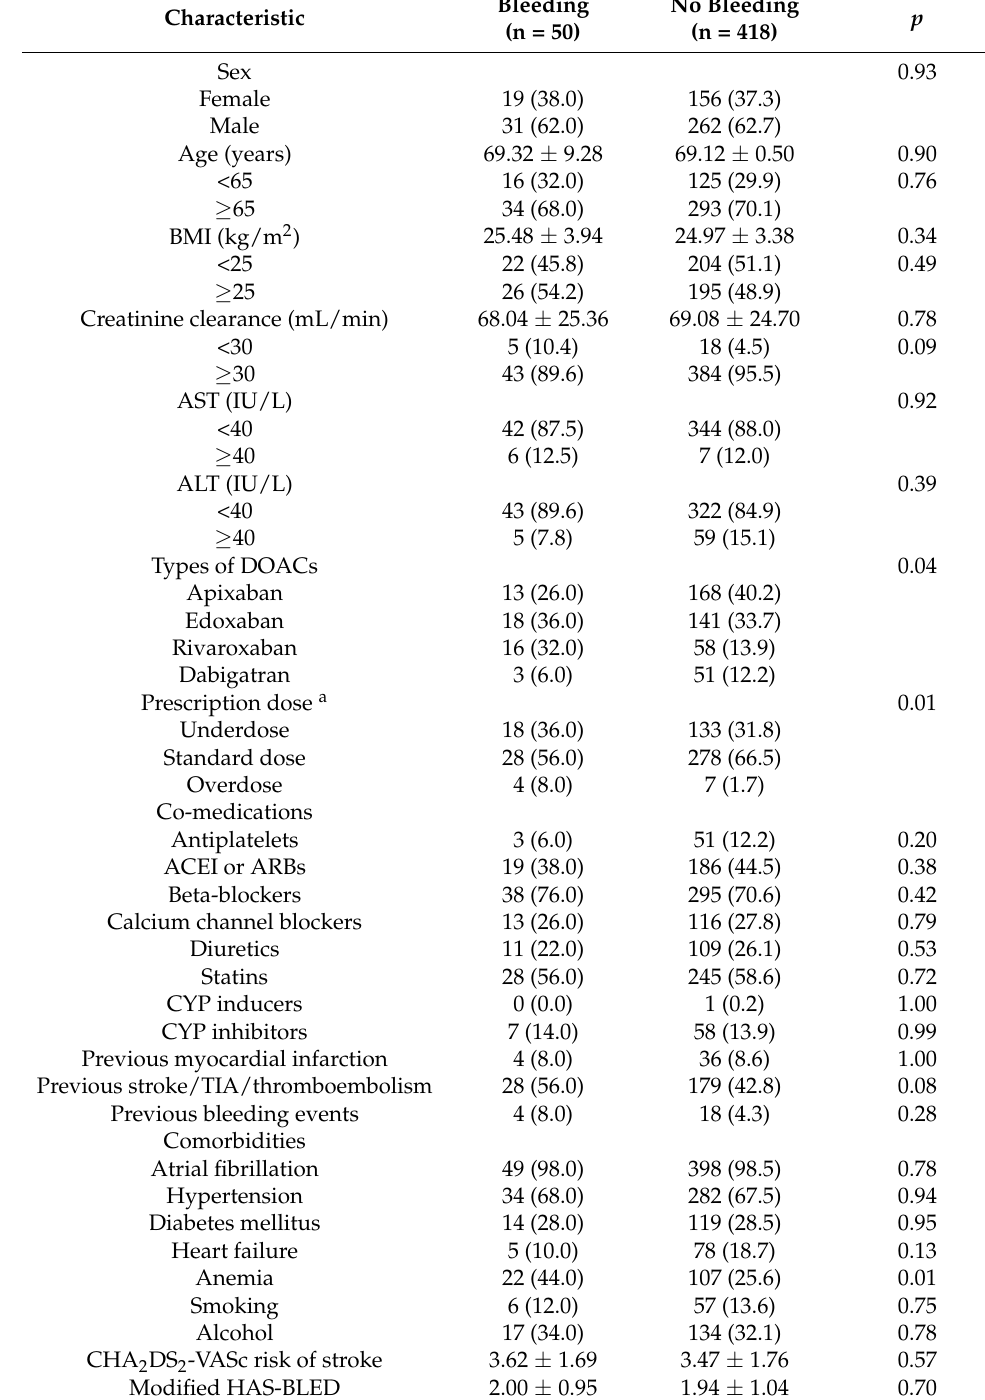
Table 1. Baseline characteristics of patients included in this